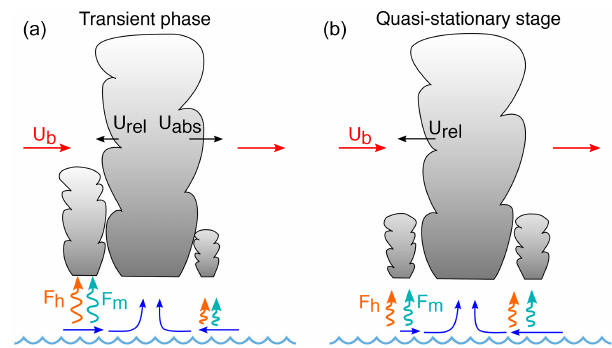
Figure 7. Sketch of the convective cluster, the surface wind field, the imposed mean wind ( u b ), the surface enthalpy flux ( F h ), and the momentum flux ( F m